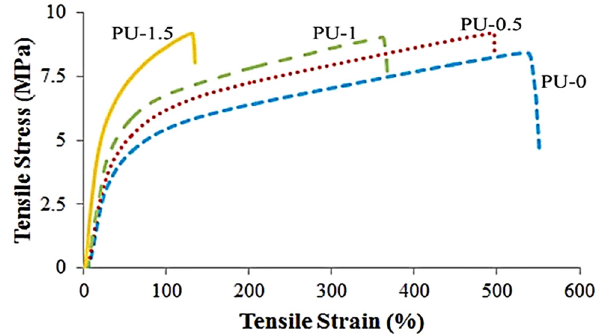
Figure 11: Typical tensile stress - strain curves of polyurethane/gra - phene nanoplatelet nanocomposites ( 106 ) . PU – polyurethane. Reproduced with permission from